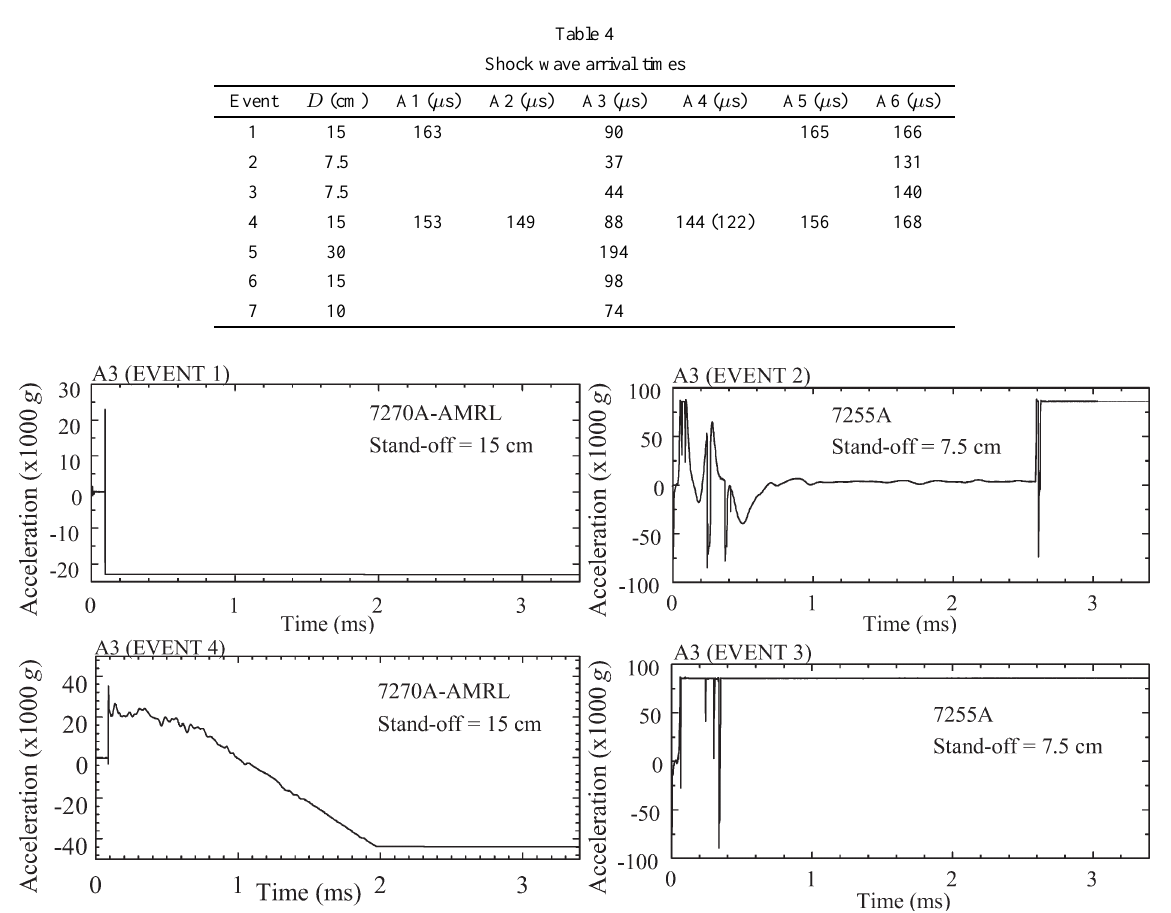
Fig. 10. Acceleration results for location A3 at 7.5 and 15 cm stand-off distances, from 10 g of PE4. from the explosion and high voltage firing